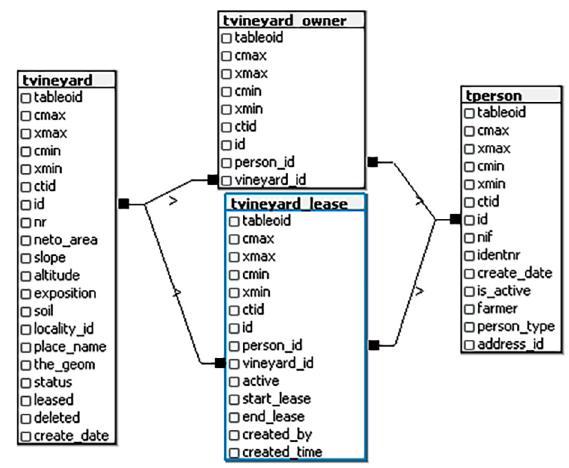
Figure 10. Table relationships